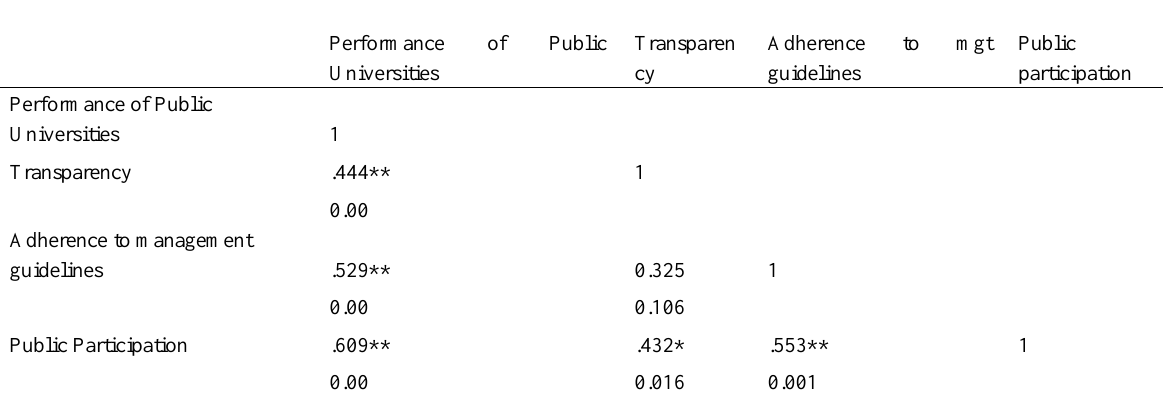
Table 8: Correlation Analysis